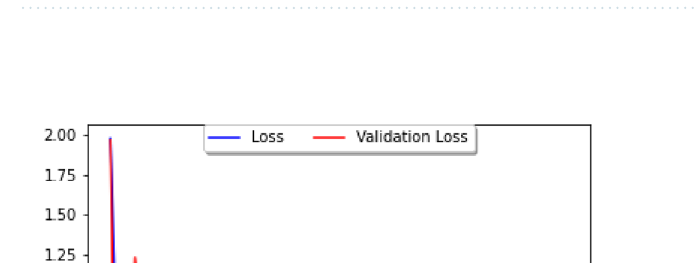
Figure 12. The loss curve for only climate factors.